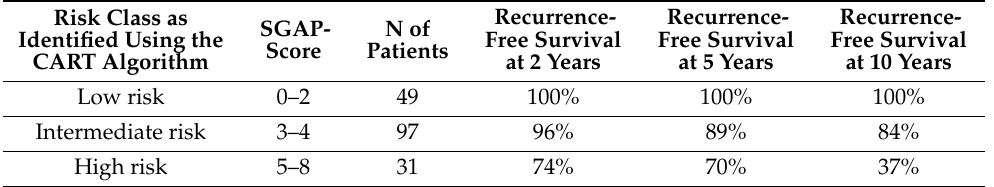
Table 3. Recurrence-free survival at 2 years, 5 years, and 10 years according to the SGAP-score risk classes. Abbreviations: CART, classification and regression tree; N, number; SGAP, Size–Genetic–